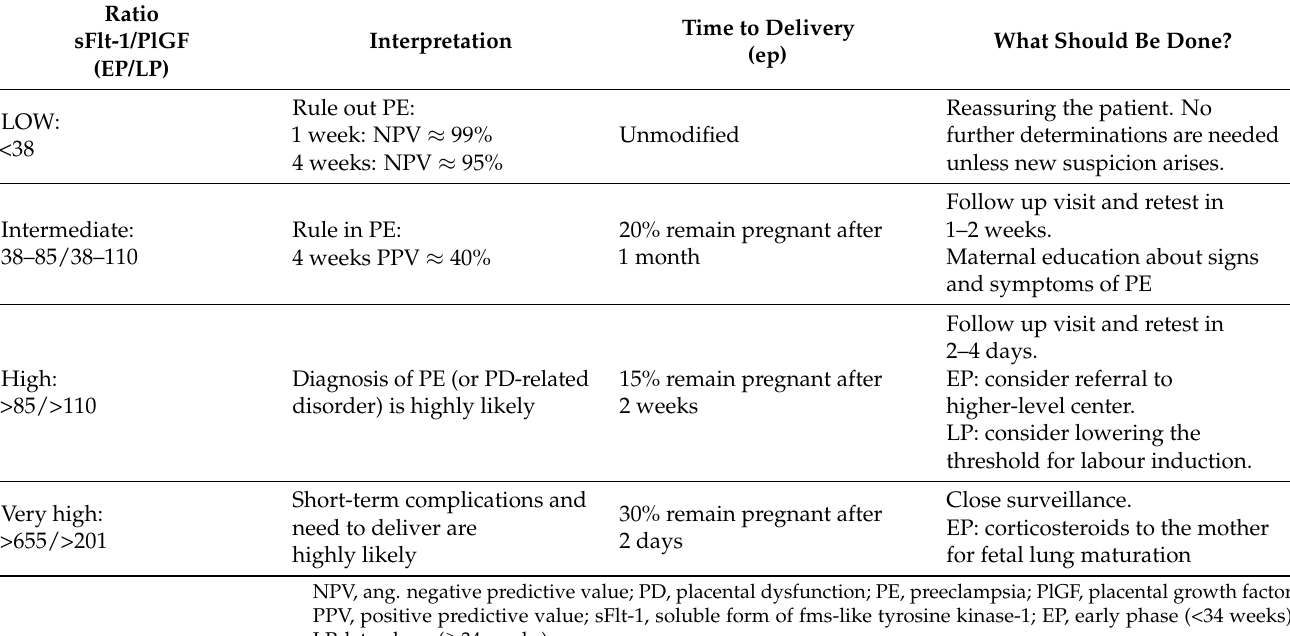
Table 13. Summary of the recommendations for the use of sFlt-1/PlGF ratio in women with signs and symptoms of PE based on the opinion of experts in the use of angiogenic